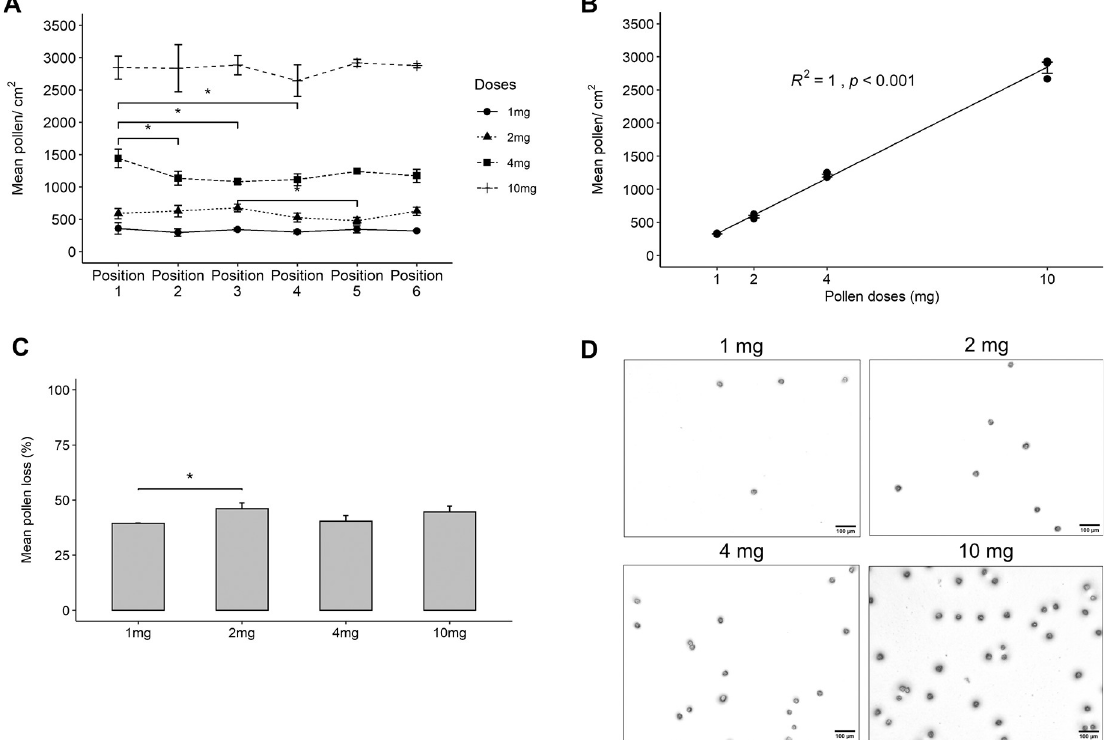
Fig 3. Distribution and dose effect curve of pollen dosing. (A) pollen dose depending on dose and position in the chamber, (B) dose effect curve, (C) loss of pollen to the chamber depending on dose, (D) Microscope pictures of surface distribution of pollen, for the different doses, within single positions. N � 3 in all